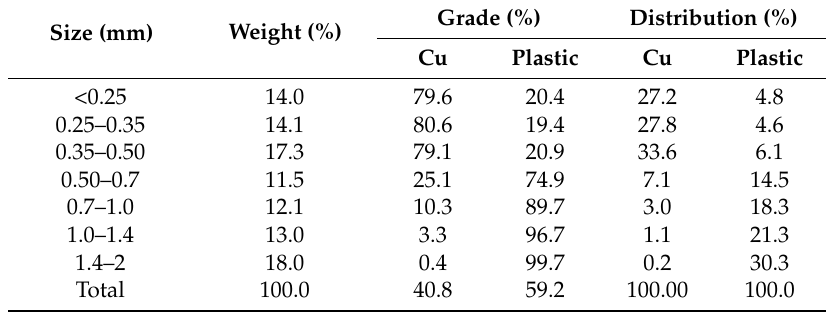
Table 1. Size and assay distribution of copper and plastic of granulates electrical cable waste. Size (mm)